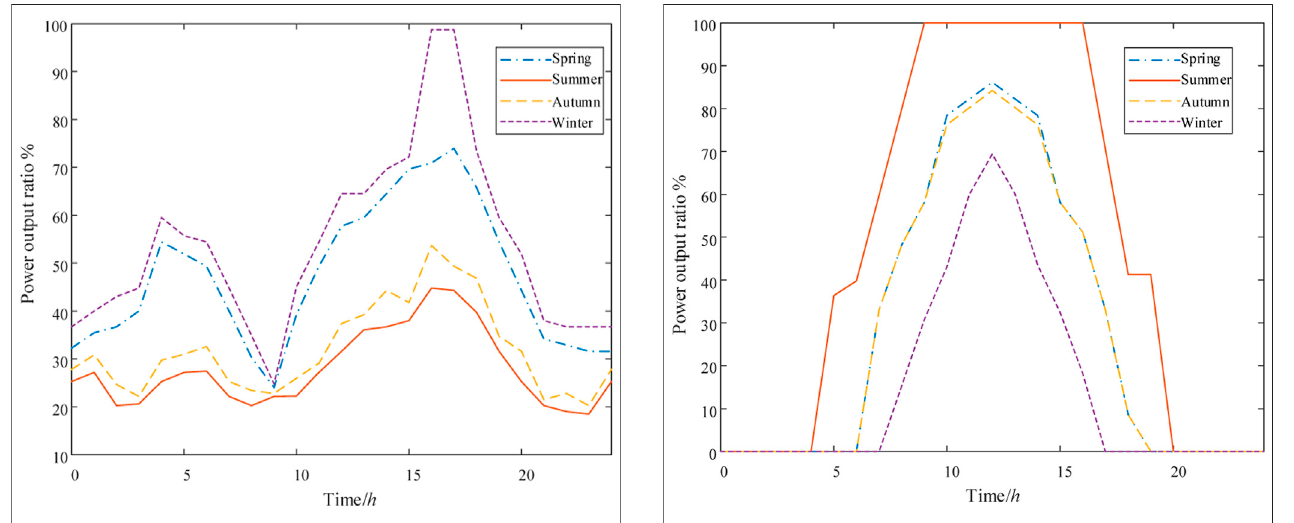
FIGURE 1 | Annual output curve of wind turbine. FIGURE 2 | Annual output curve of PV system.